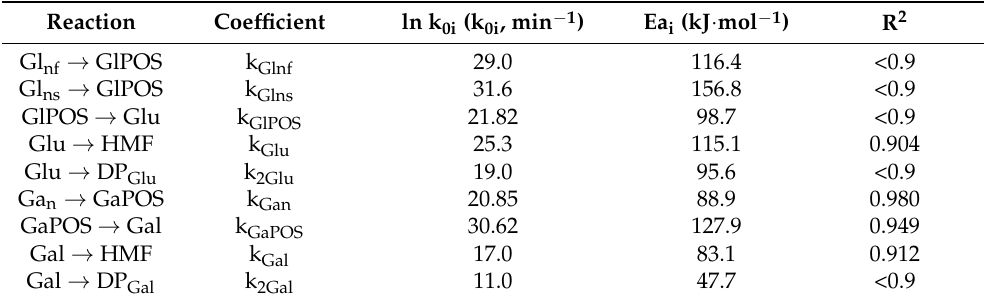
Figure 2. Mechanism proposed for the kinetic modeling of MxG autohydrolysis. The preexponential factors, the activation energies, and the susceptible glucan fraction obtained by fitting the experimental data to the above equations are listed in Table 4. Table 4. Results calculated for the parameters (preexponential factors, activation energies, and regression coefficients) governing the reactions of polysaccharides made up of hexoses and the derived